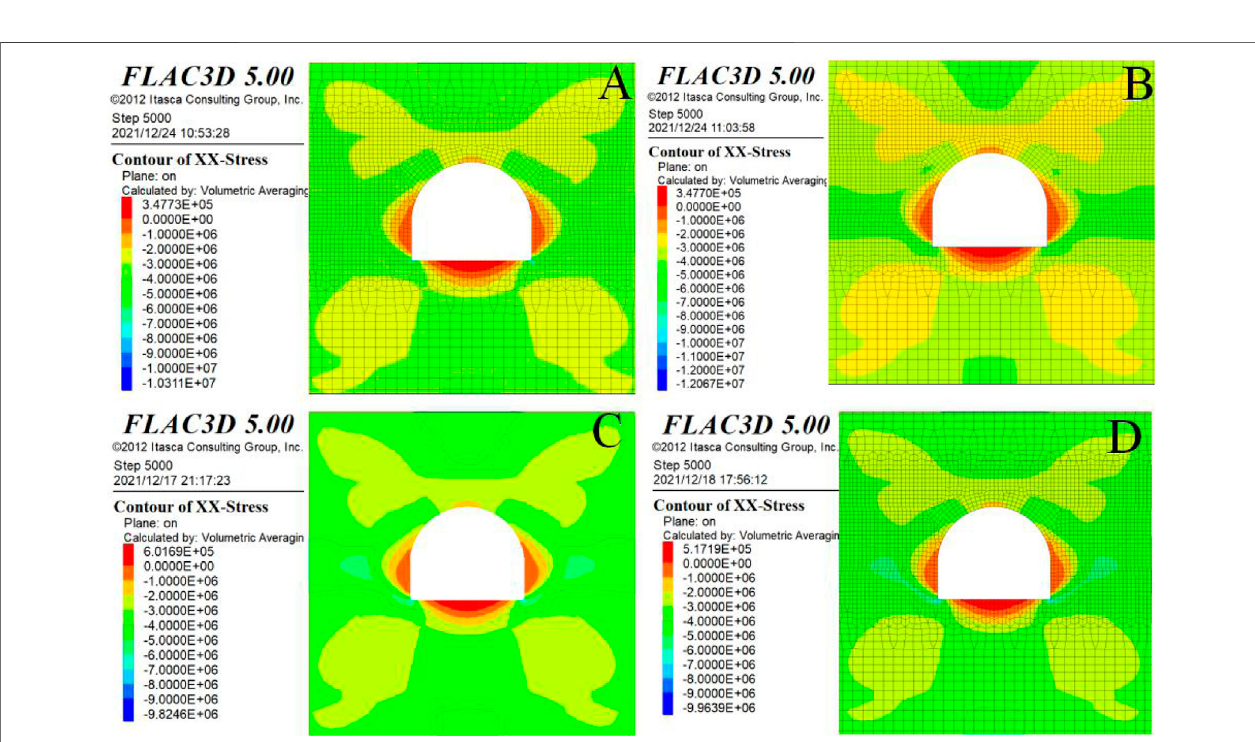
FIGURE 7 | Cloud diagram of ZZ stress distribution. (A) Option 5. (B) Option 6. (C) Option 7. (D) Option 8.